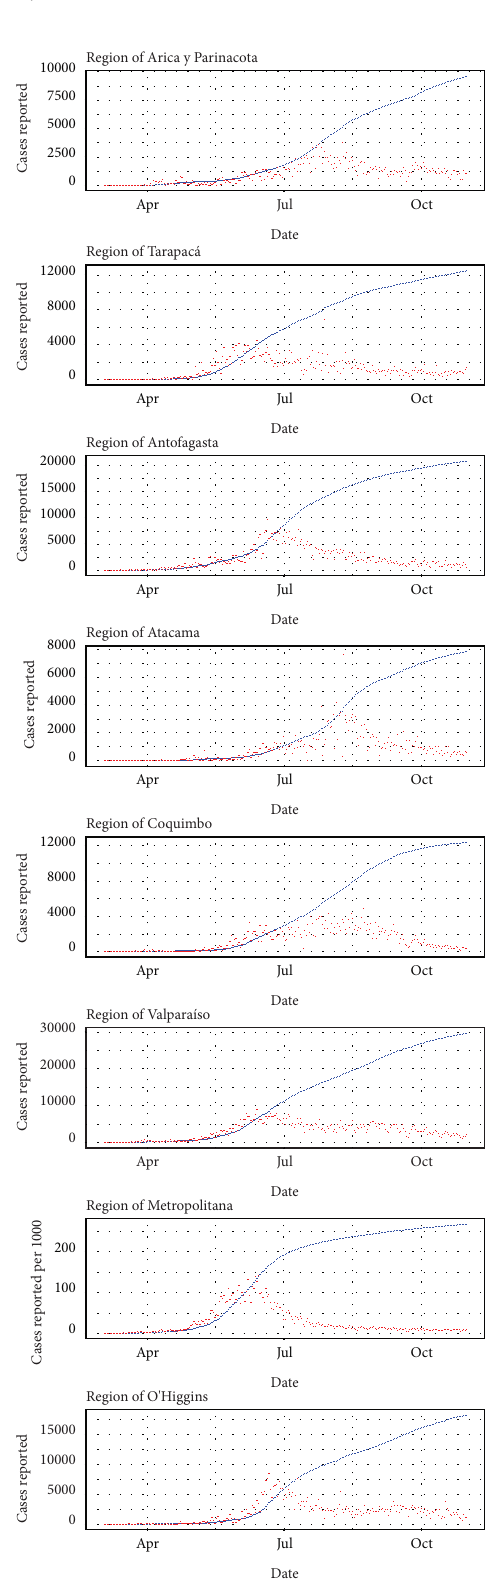
Figure 14: Cumulative (in blue) and daily (in red) number of infected by COVID-19 in the most afected regions of Chile. Te data record covers from March 22 to November 30, 2020. Te daily cases are magnifed by 25 to better appreciate